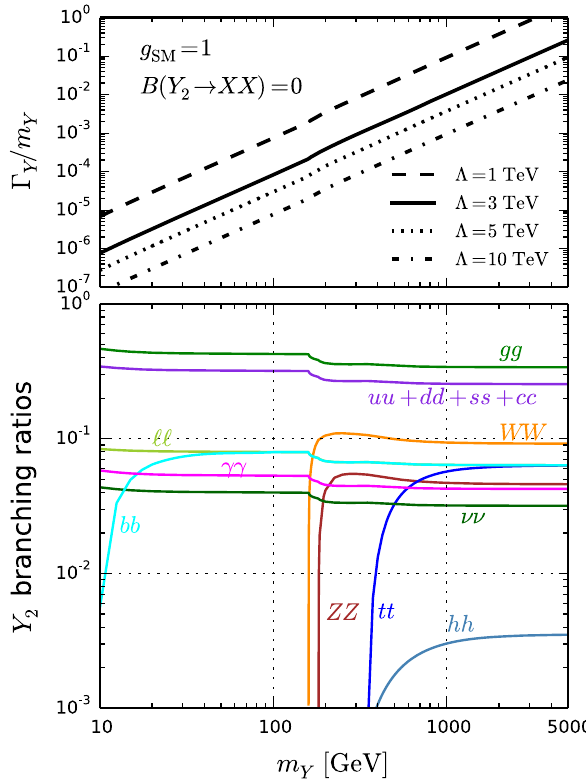
Fig. 1 Ratio of the mediator total width to its mass, Γ Y / m Y , ( upper panel ) and mediator branching ratios ( lower panel ) as a function of the mediator mass m Y for g SM = 1, where we assume a negligible branching ratio to the dark sector